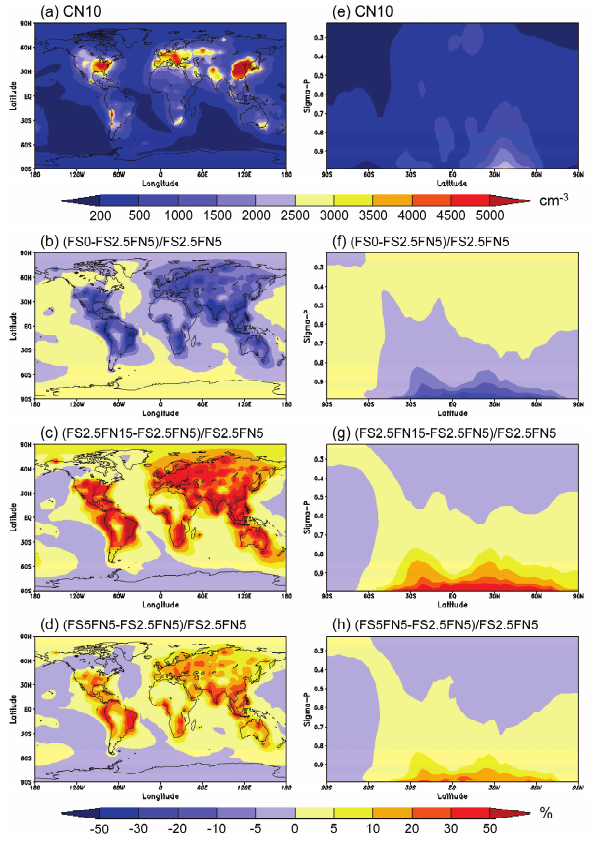
Fig. 4. Same as Fig. 1, except for the number concentration of condensation nuclei large than 10nm (CN10).